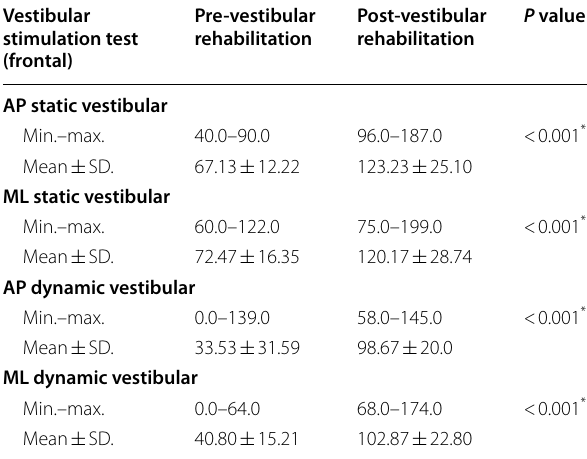
Table 10 Vestibular stimulation test with frontal head movement before and after vestibular